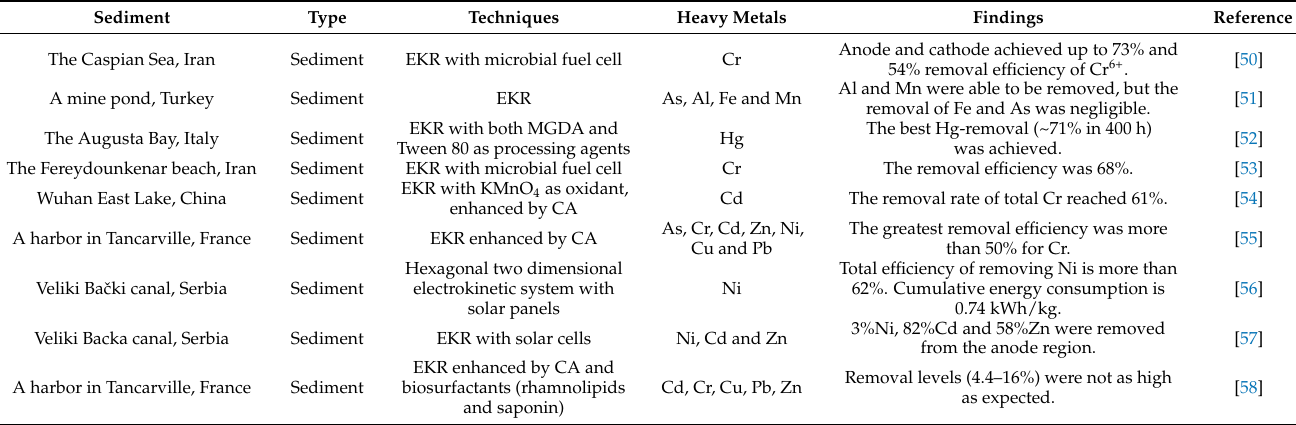
Table 2. Ex situ EKR for heavy metal contaminated sediment in recent